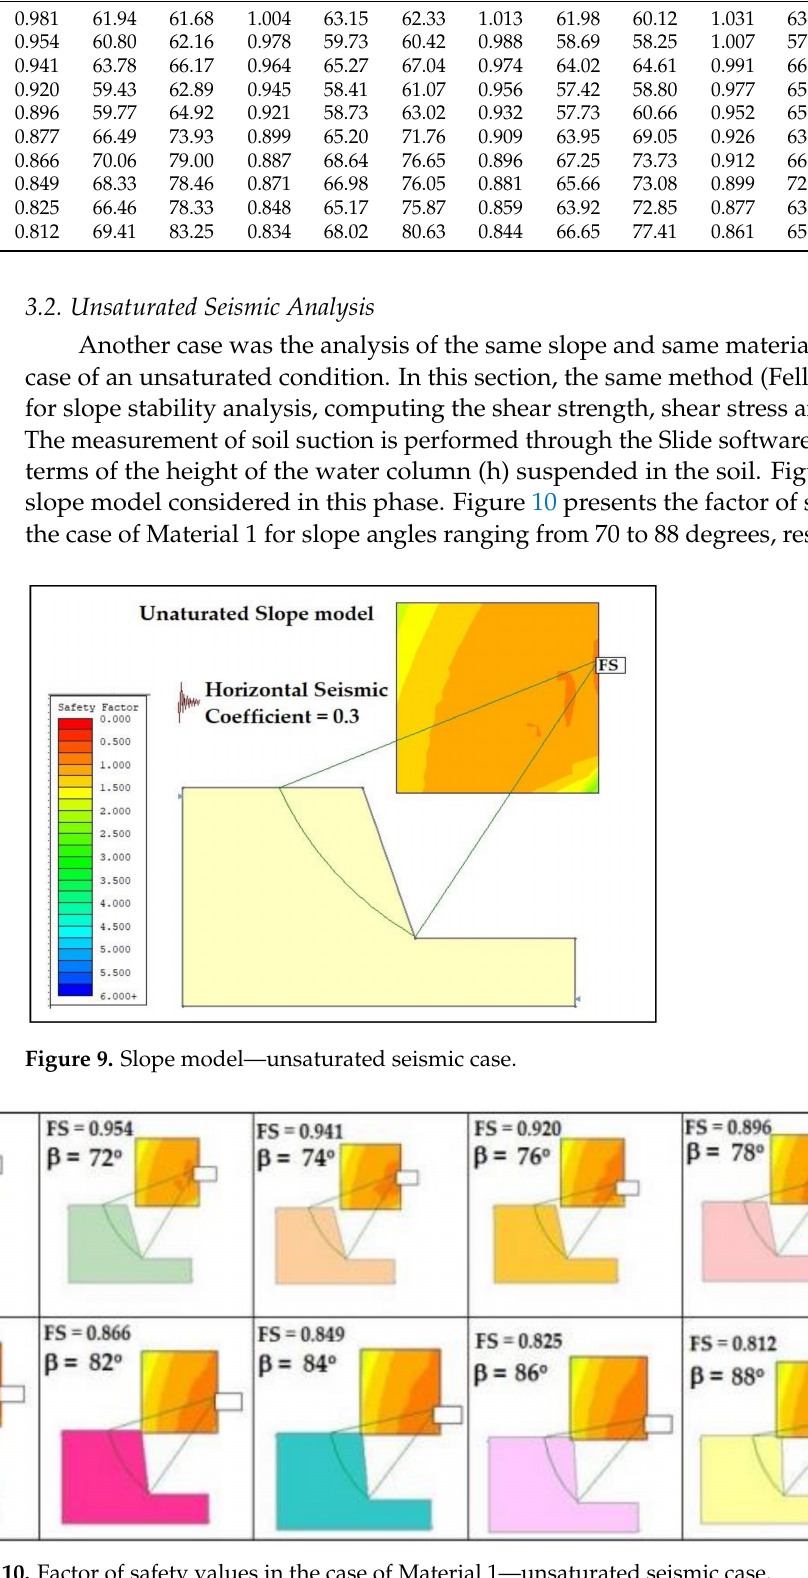
Figure 10. Factor of safety values in the case of Material 1—unsaturated seismic